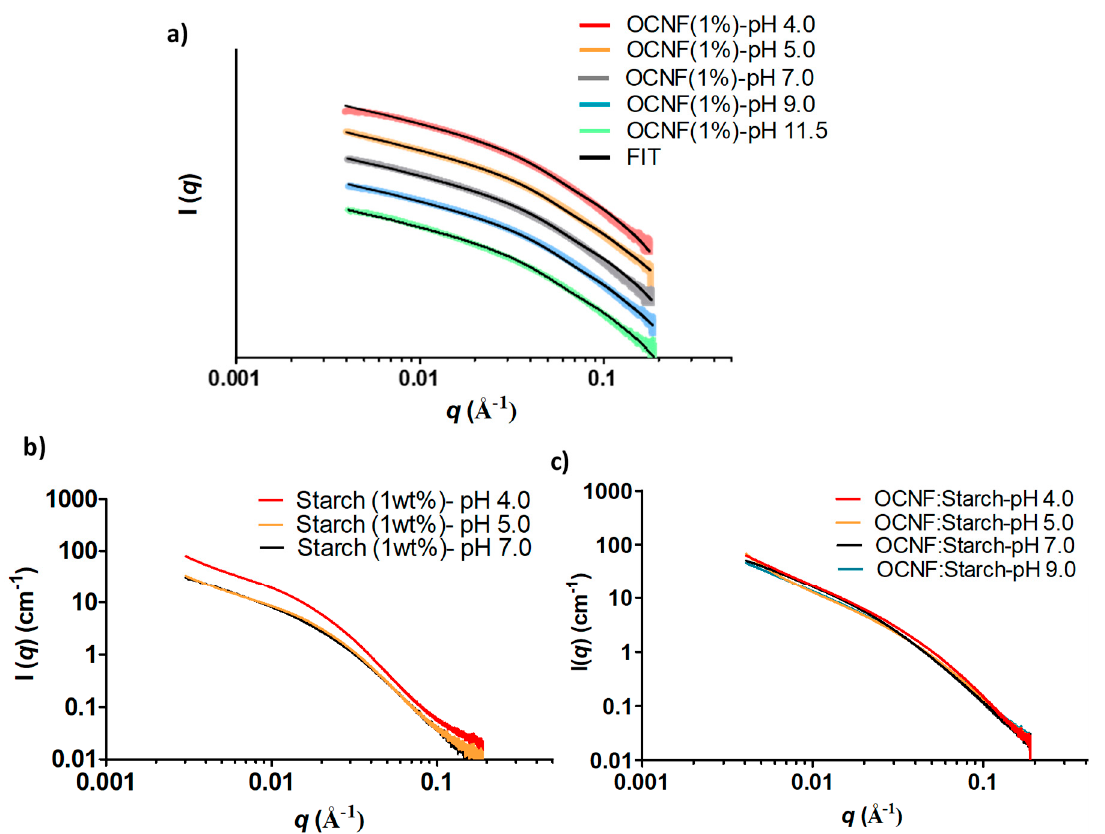
Figure 10. SAXS patterns of the gels at various pH: ( a ) OCNF (1 wt%) (offset was used for clarity), ( b ) starch (1 wt%), and ( c ) OCNF:starch (1:1 wt%).